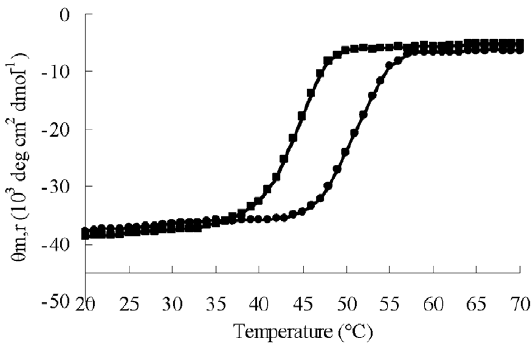
N Figure 4. Heat-induced denaturation of RCLCYS and RCL. CD ) and RCL ( & ) were recorded at 220 nm at the spectra of RCLCYS ( temperatures indicated.